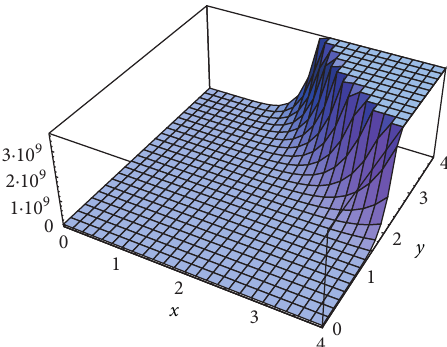
Figure 5: Graphical representation of M-polynomial where p �